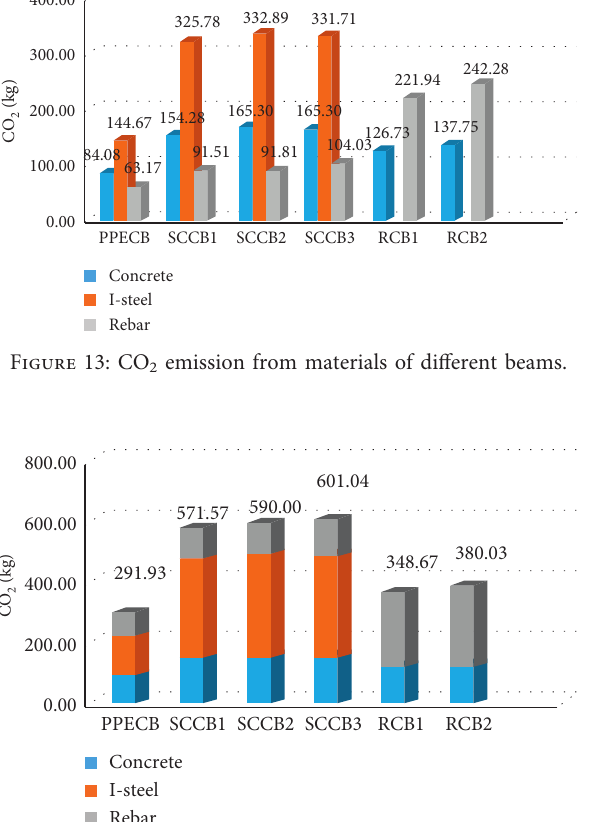
Figure 12: The cost of each beam. Table 9: CO 2 emission rate.